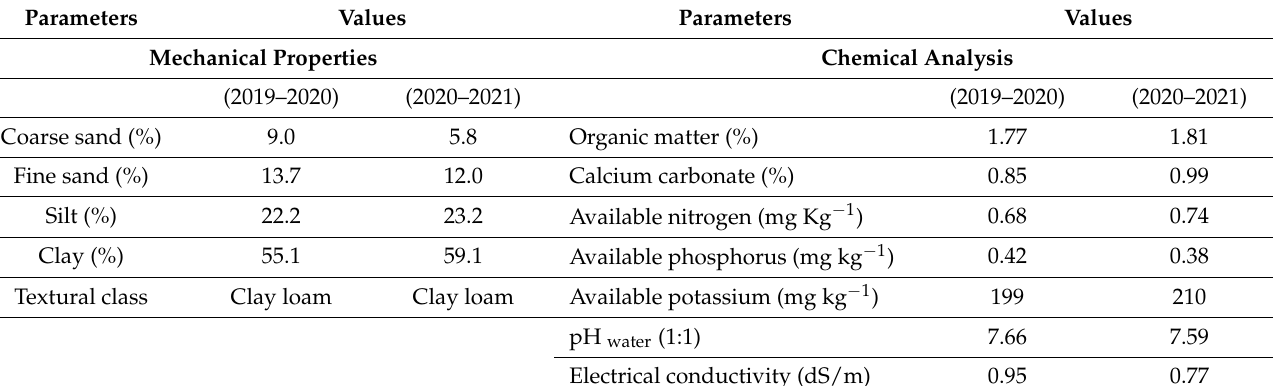
Table 1. Mechanical and chemical analysis of the experimental